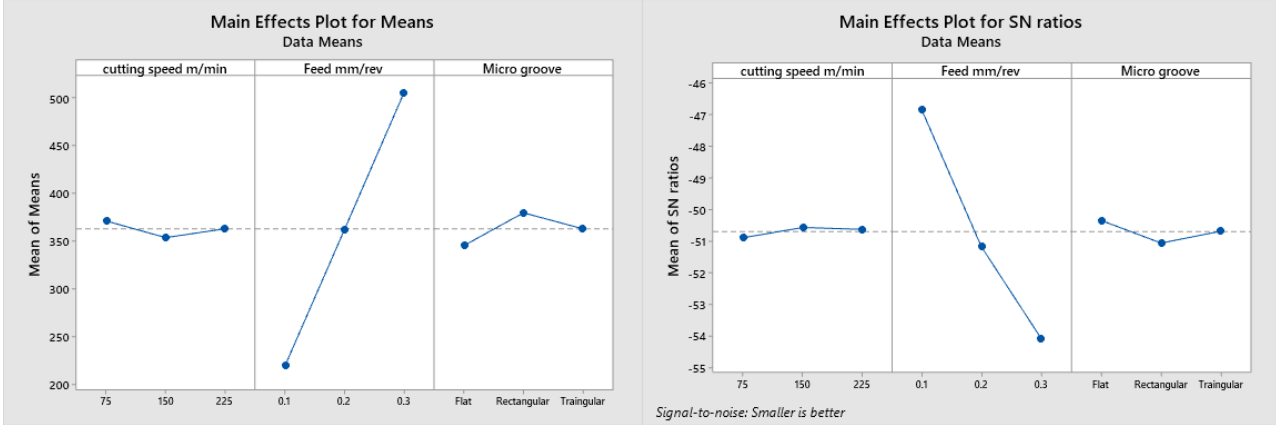
2 Table 9 Total cutting power: Mean response. Level